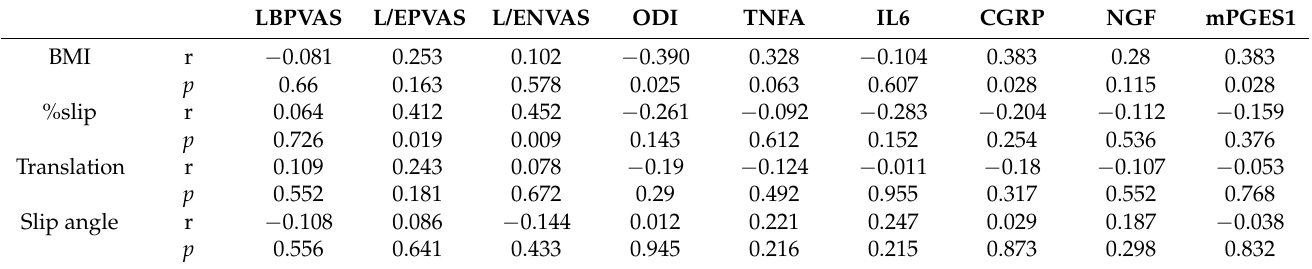
Table 1. Correlation between factors for mechanical stress or axial loading on IVDs and clinical findings or the expression of pain-related molecules.